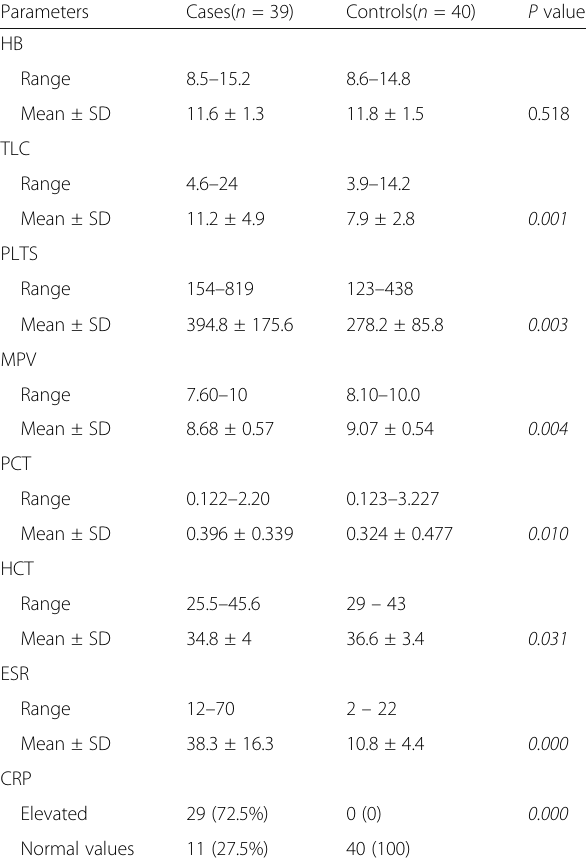
Table 1 Comparison between cases and controls regarding CBC findings and other labs Parameters